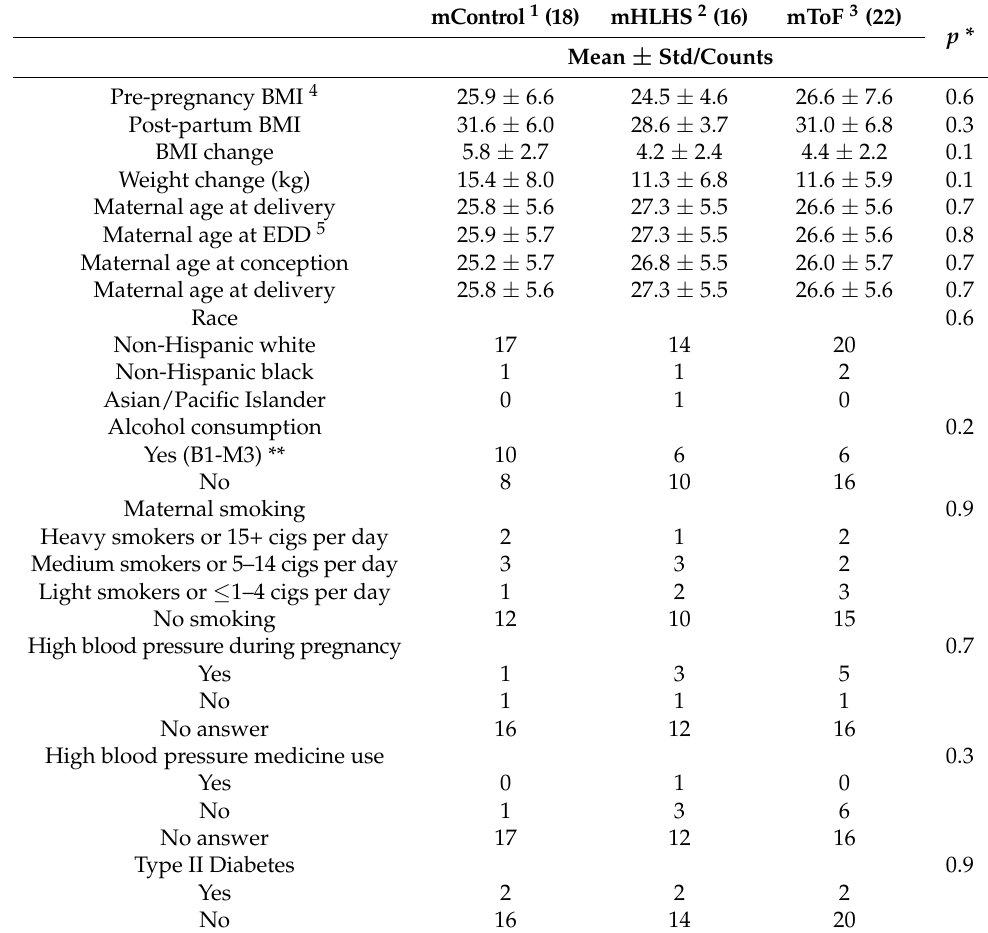
* p -values represent differences between groups. Continuous variables were evaluated by ANOVA, and chi square ( X 2 ) tests were used to investigate the differences in distributions of categorical variables. 1 mControl: mothers of unaffected offspring; 2 mHLHS: mothers of offspring with hypoplastic left heart syndrome; 3 mToF: mothers of offspring with tetralogy of Fallot; 4 BMI: body mass index; 5 EDD: estimated due date. ** One month before conception to end of first